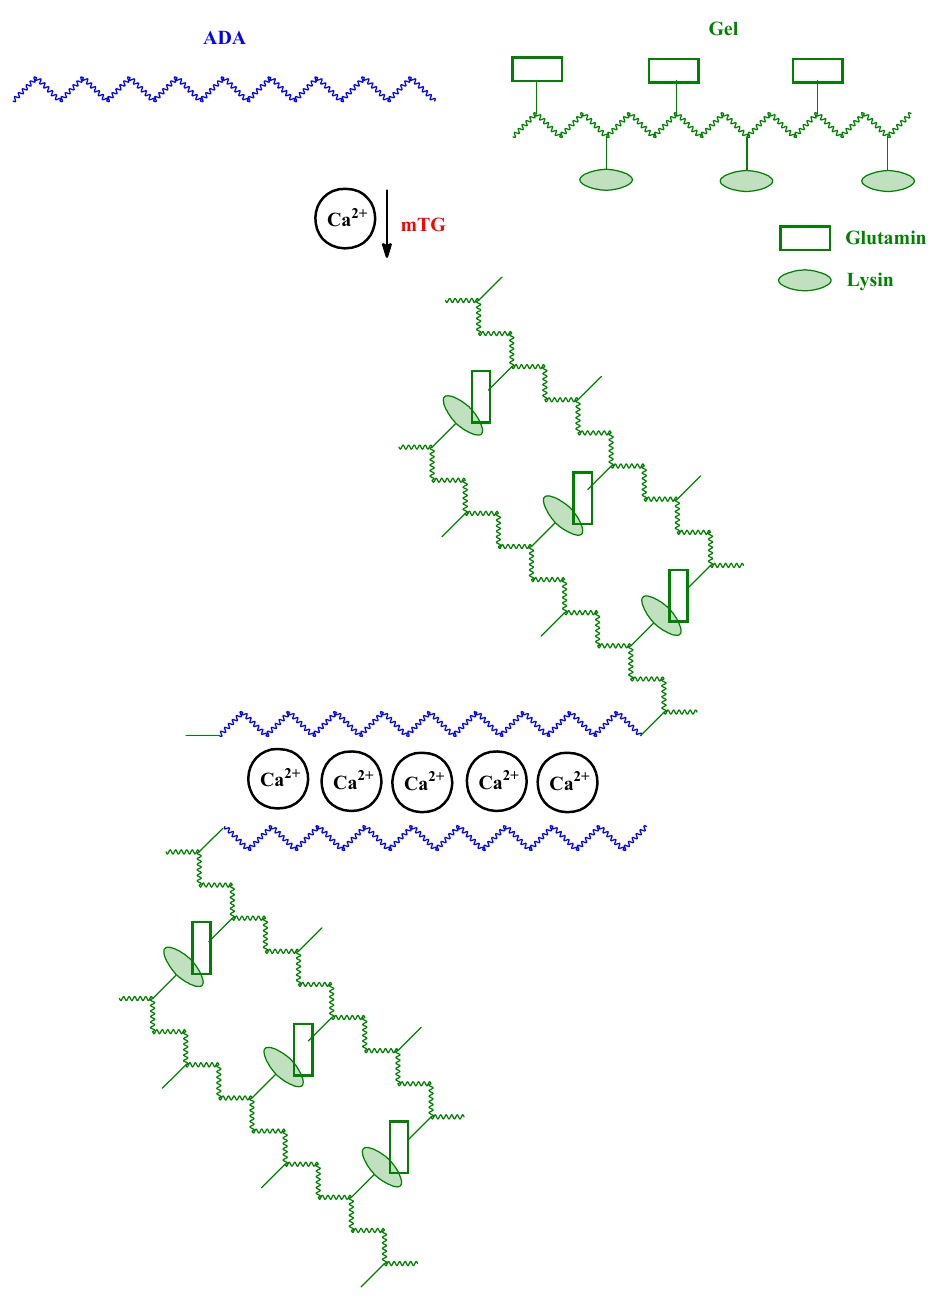
Figure 6. Microbial (mTG) and Ca 2+ cross-linked ADA-Gel hydrogel.